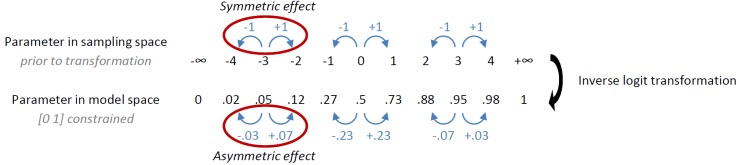
DOI:
http://dx.doi.org/10.7554/eLife.22169.028